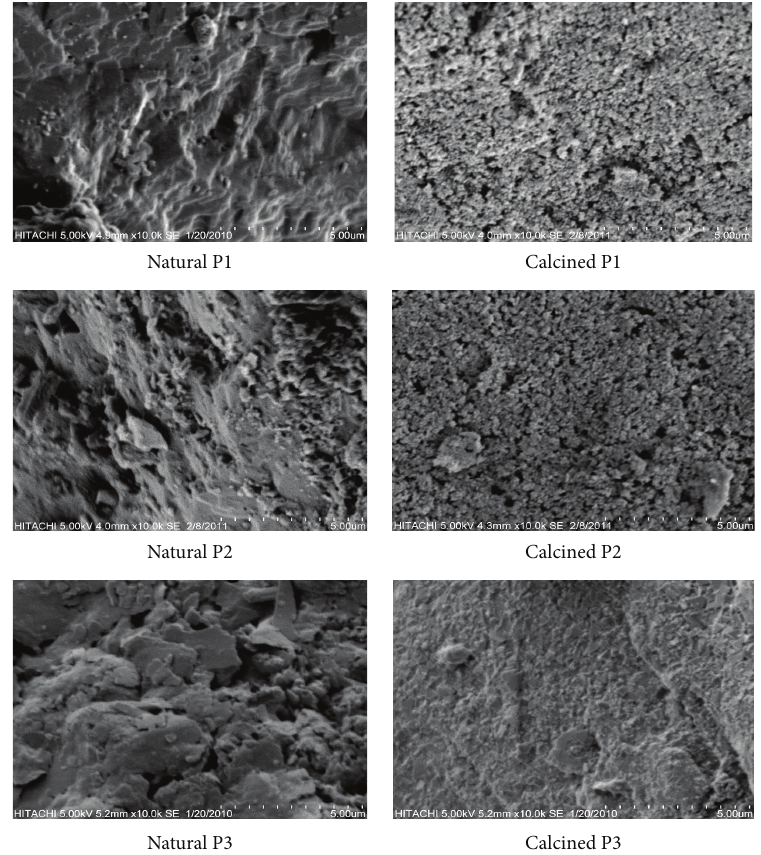
Figure 5: SEM microphotograph of natural and calcined Malaysian dolomites.